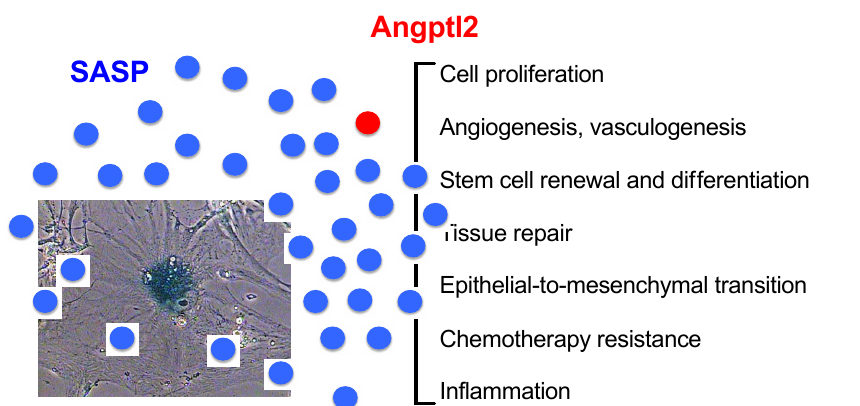
Figure 2. Similar functional characteristics of the SASP and of angptl2. Adapted from [2].